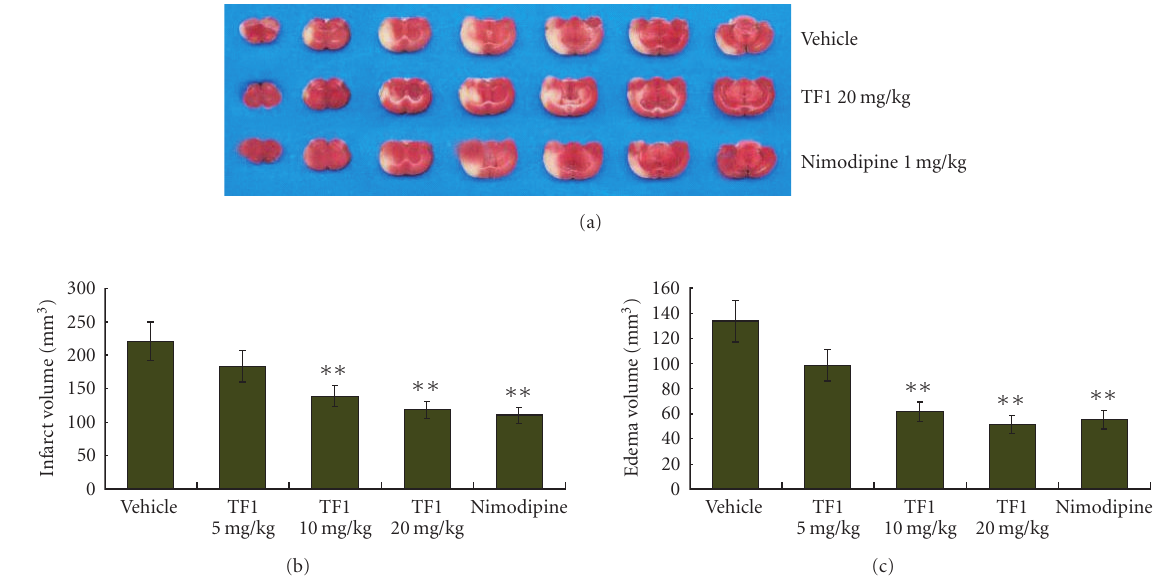
Figure 1: (a) Representative coronal brain sections stained with TTC after 2hours of MCAO and 24 hours of reperfusion showing infarction. Dark-colored region in the TTC stained sections indicated nonischemic portion of brain and pale-colored region indicated ischemic portion of brain. Theaflavin and nimodipine-treatment reduced infarct volume. (b) Volume of infarction after 2 hours of MCAO and 24 hours of reperfusion in vehicle, theaflavin (5, 10, and 20mg/kg) and nimodipine (1mg/kg)-treated rats. (c) Volume of edema after 2hours of MCAO and 24hours of reperfusion in vehicle, theaflavin (5, 10, and 20mg/kg) and nimodipine-treated (1mg/kg) rats, ∗∗ P < . 01 as compared to the vehicle-treated group.